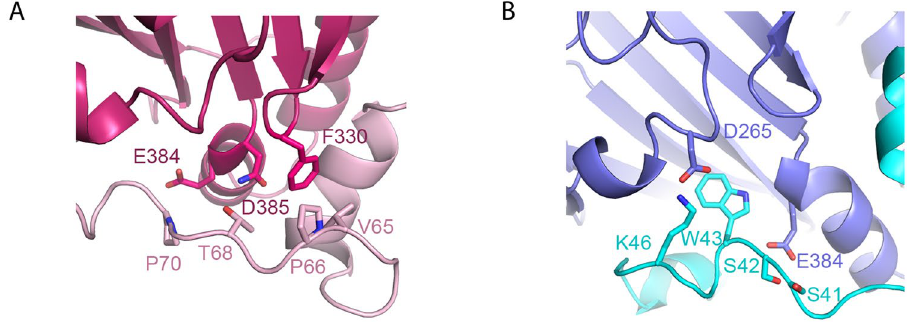
Figure 3. Comparison of YAP-TEAD and TAZ-TEAD structures. ( A ) Interactions between residues on the loop of YAP (pink) and TEAD (red), differ from that of the ( B ) residues on the shorter loop of TAZ (cyan) and TEAD